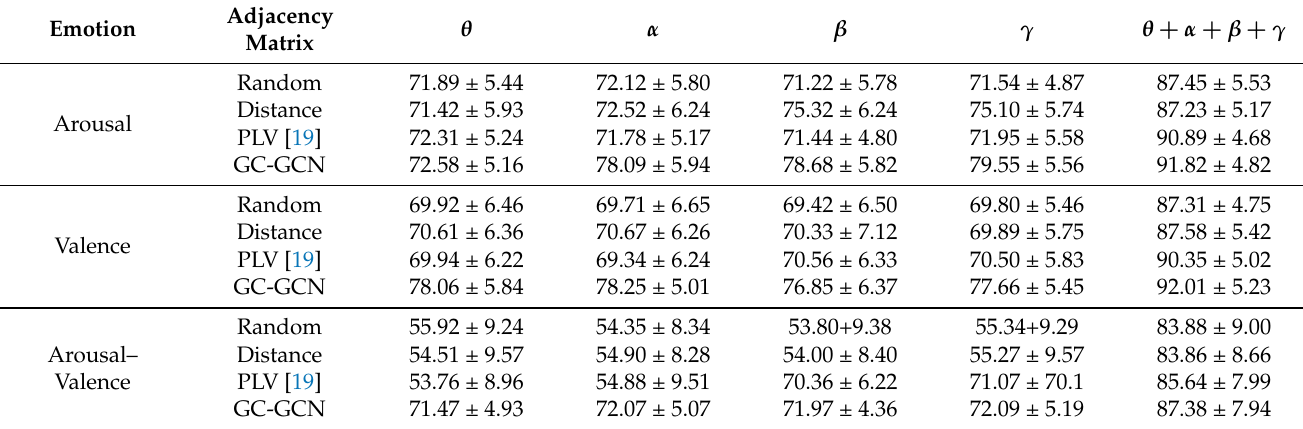
Table 2. The recognition performance of the GCN features with different adjacency matrices